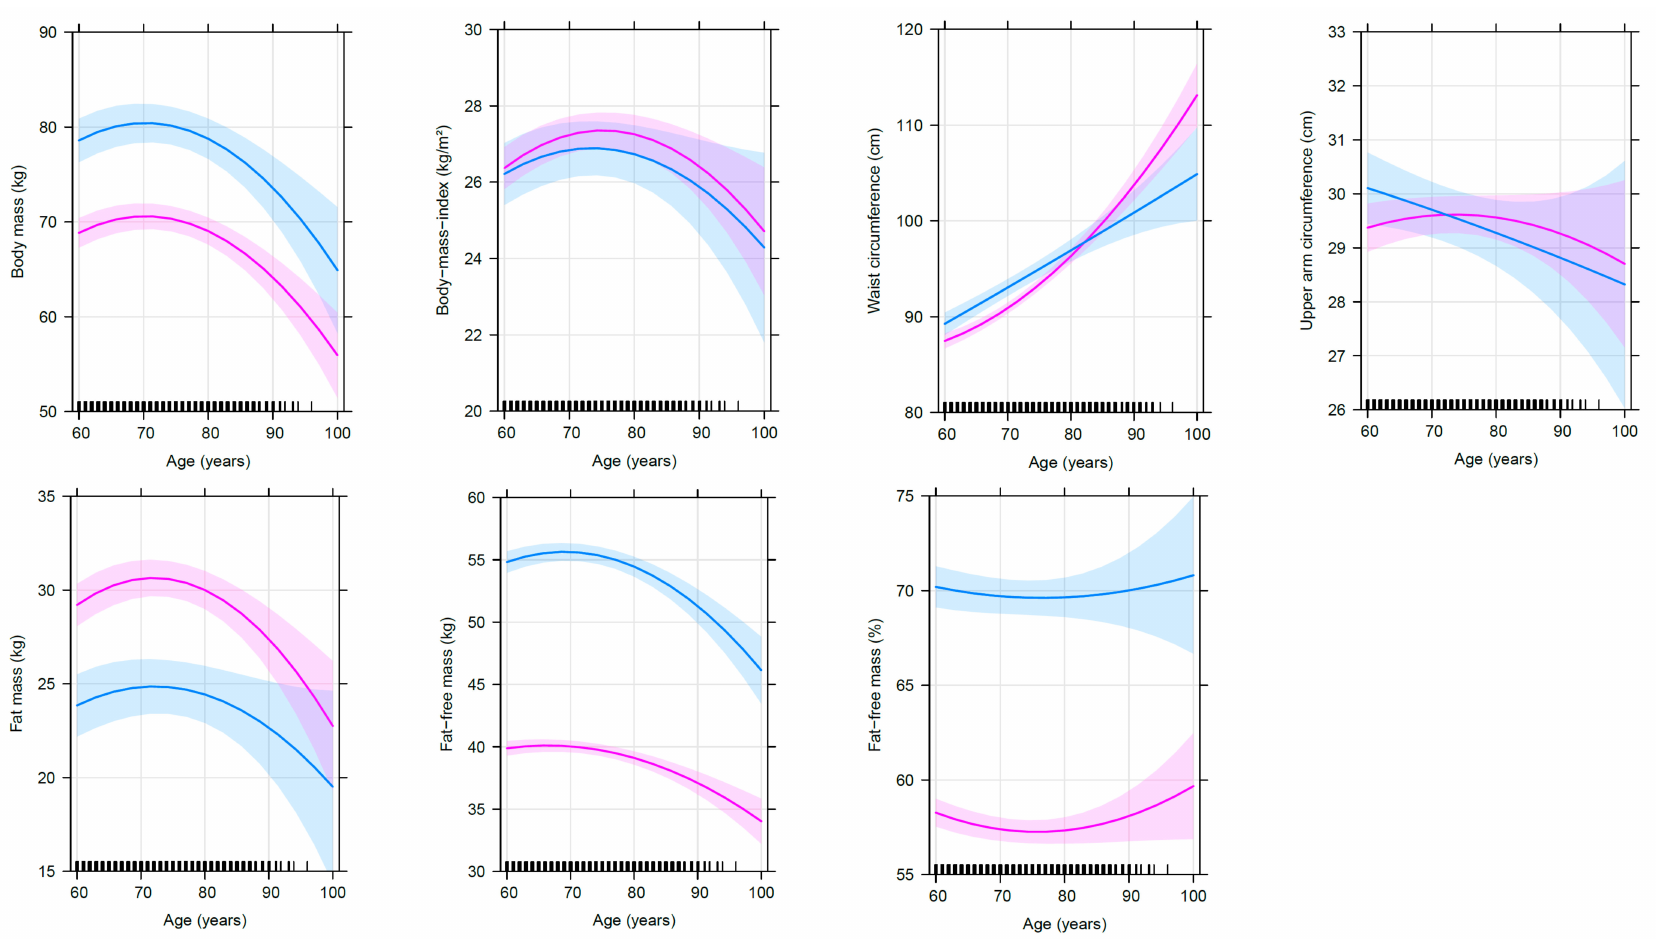
Figure 2. Age-related changes in anthropometric and body composition parameters separated by sex. This figure illustrates the selected e ff ects of age and sex on anthropometric and body composition parameters after controlling for other variables in the linear mixed-e ff ects models ( n = 401). The thick lines represent the estimated means and the respective colored areas reflect the 95% confidence intervals. The associations are illustrated in magenta and blue color for female ( n = 278) and male ( n = 123) subjects, respectively. The small black pillars on the x -axis reflect the numbers of records at the respective age of the